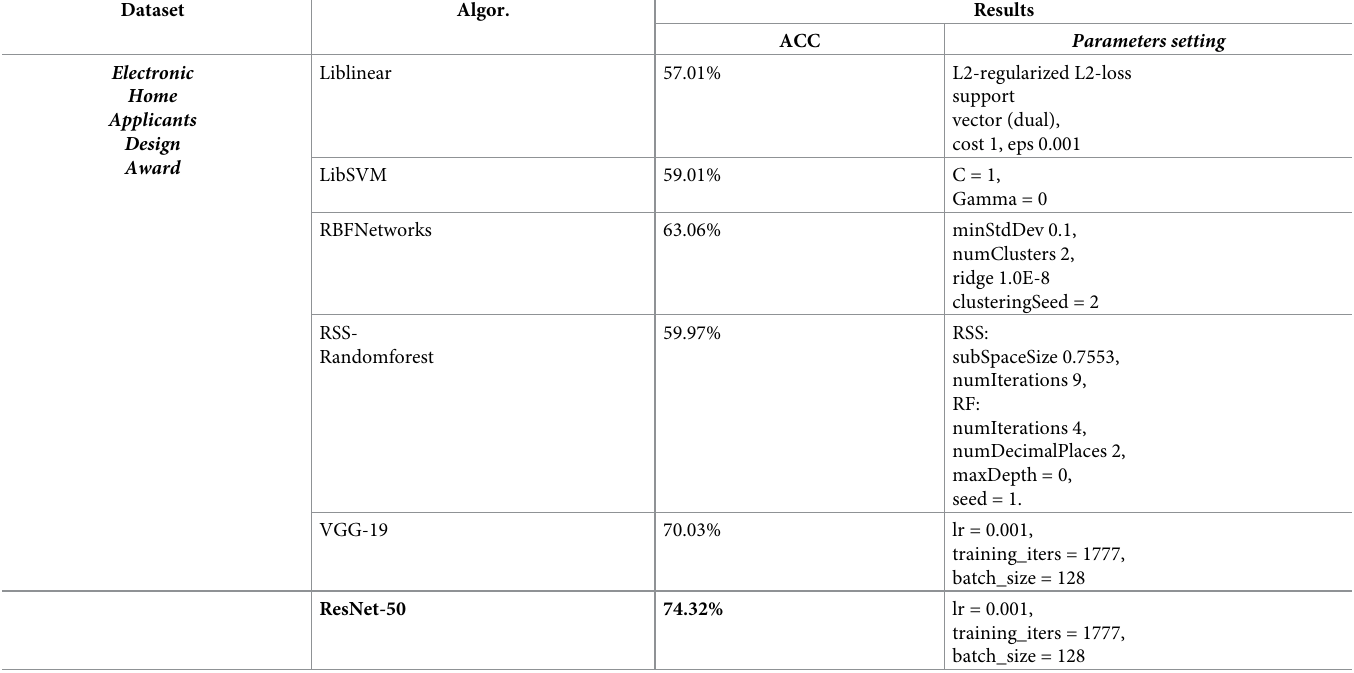
Table 5. Aesthetic-aware classification accuracy of the dataset from the Electronic Home Applicants Design Awards. Dataset Algor. Results ACC Parameters